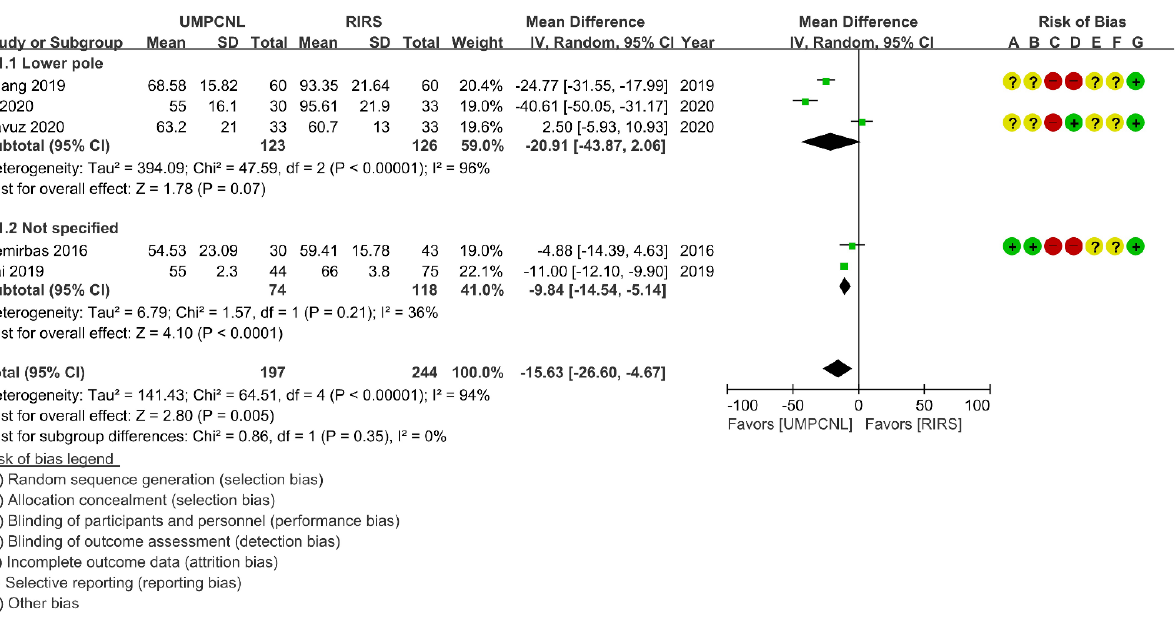
Figure 5. Comparison of UMPCNL and RIRS in terms of the operative time.